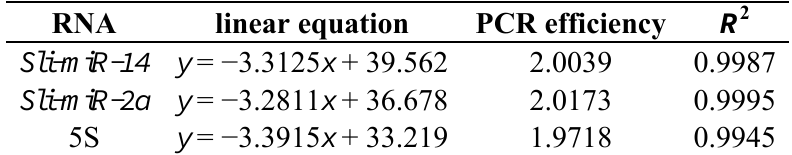
Table 1. Efficiency of amplification for miRNAs and 5S